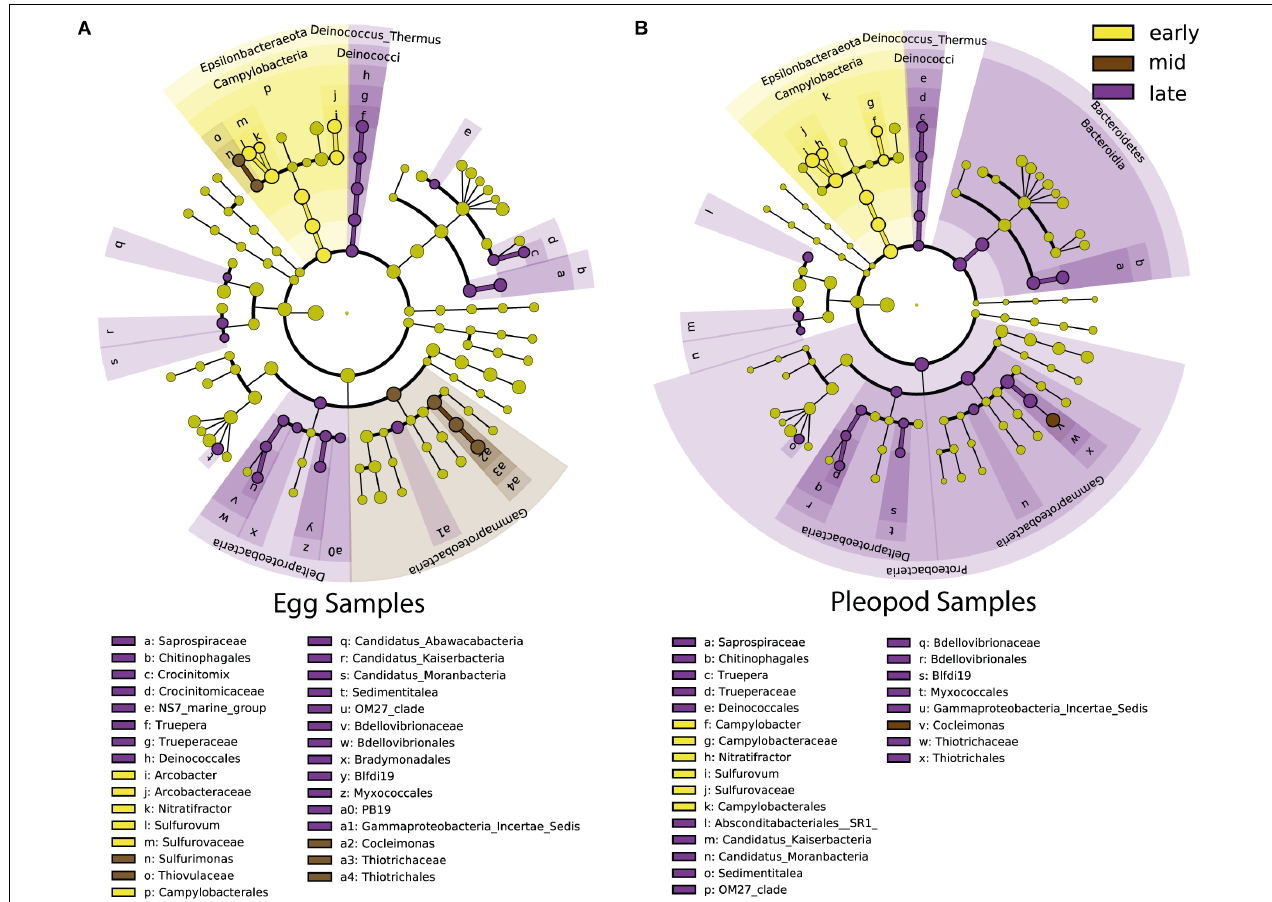
FIGURE 6 | Most differentially abundant taxa of egg communities (A) and pleopod communities (B) between early stages (yellow), middle stages (brown) and late stages (purple). The dots represent the specific bacterial taxa, with colors corresponding to the stage where these are relatively more abundant, yellow-greenish color denoting taxa with no significant difference in relative abundance between stages. The size of dots is proportional to the relative